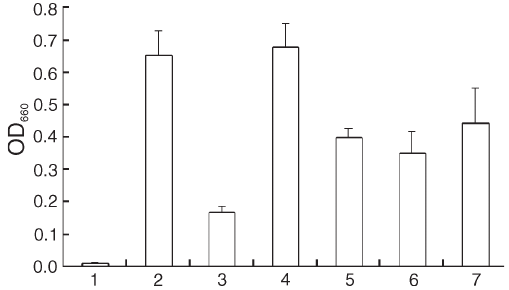
Figure 2. Disaggregating activity of soluble fractions extracted from recombinant Escherichiacoli BL21(DE3)pLysS. The activitywas de- termined with aggregated cells of strain S-6 T as substrate in K-P buffer by the turbidimetric assay as described in the Materials and methods. Blank, only substrate; 1, culture supernatants of Methano- sarcina mazei grown as single cells with substrate (positive control); 2, culture supernatants of M. mazei grown as aggregates (negative control) with substrate; 3, soluble fractions of induced cells contain- ing the expression plasmid (pET-39b(+)- dag ) with substrate; 4, solu- ble fractions of uninduced cells containing the expression plasmid with substrate; 5, soluble fractions of induced cells containing the ex- pression plasmid without substrate; and 6, soluble fractions of uninduced cells containing the expression plasmid without substrate. Values for the positive and negative controls are shown as averages with aggregated cellsof M. mazei LYC (1sttrial)and TMA (2nd trial). Bar indicates the range of the values obtained from two